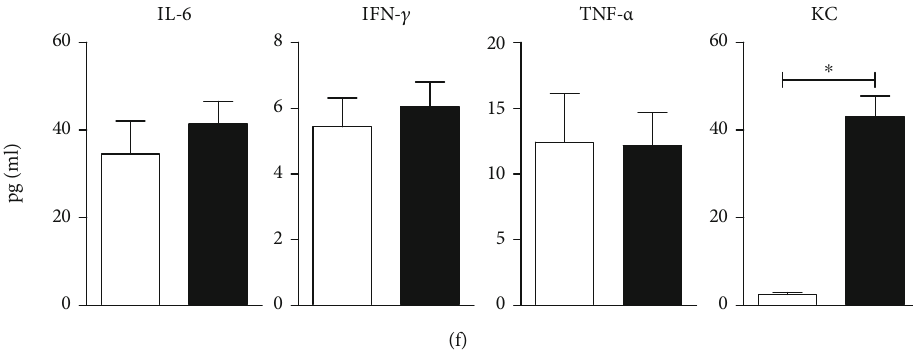
Figure 1: Characterization of the in fl ammation in BAL fl uid of CBD mice. (a) Quanti fi cation of FACS analysis of the indicated cell populations in BAL at 8 weeks after initial exposure (granulocytes (GR1 + cells), macrophages (auto fl uorescence and macrophage gate), DCs (CD11c + MHCII + ), and CD3 + T cells). (b – e) Intracellular fl ow cytometry analysis of cytokine production of BAL cells that were restimulated with PMA and ionomycin in the presence of Golgi-stop. CD3 + T cells were gated and analysed for their CD4/CD8 pro fi le (b), which was quanti fi ed (c). CD3 + CD4 + T cells were gated and analysed for intracellular cytokines (d), which were quanti fi ed (e). (f) Cytokine levels in BAL fl uid, as determined by ELISA. Mice ( n = 5 − 7 per group) were treated with PBS (controls, white bars) or Be/BeO (black bars). Mann-Whitney U test: ∗ p < 0 : 05 . Data are representative for 2 experiments